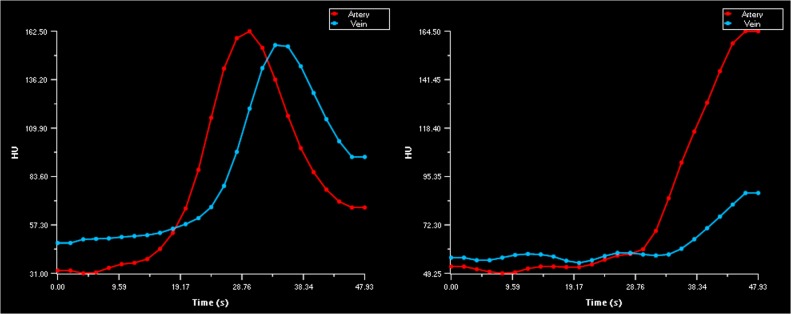
Examples of AIF and VOF truncation.Example of normal AIF curve with truncated VOF curve (left).Example of truncated AIF and VOF curves (right). For both examples longer acquisition time is needed to capture the complete in-wash and outwash of contrast agent.